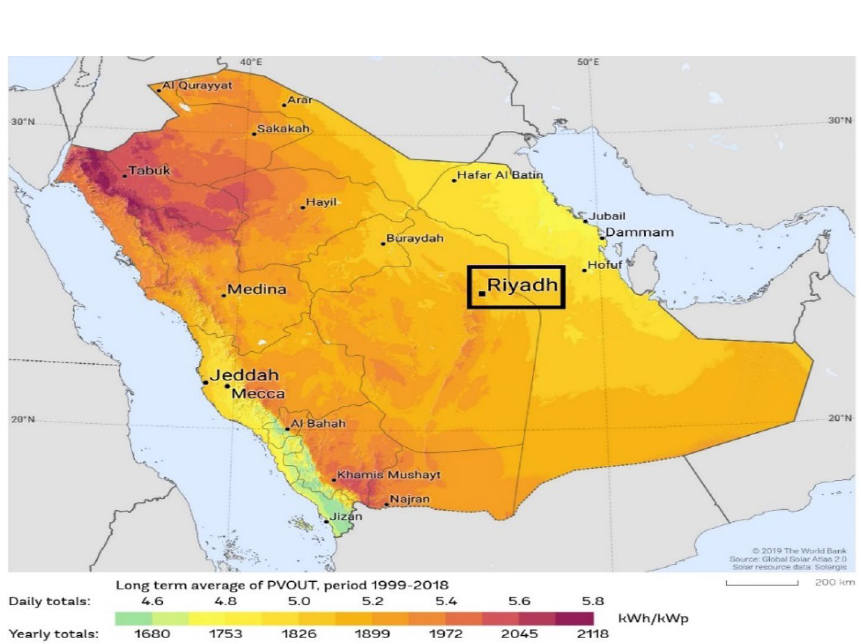
Fig. 2 Saudi Arabia solar map